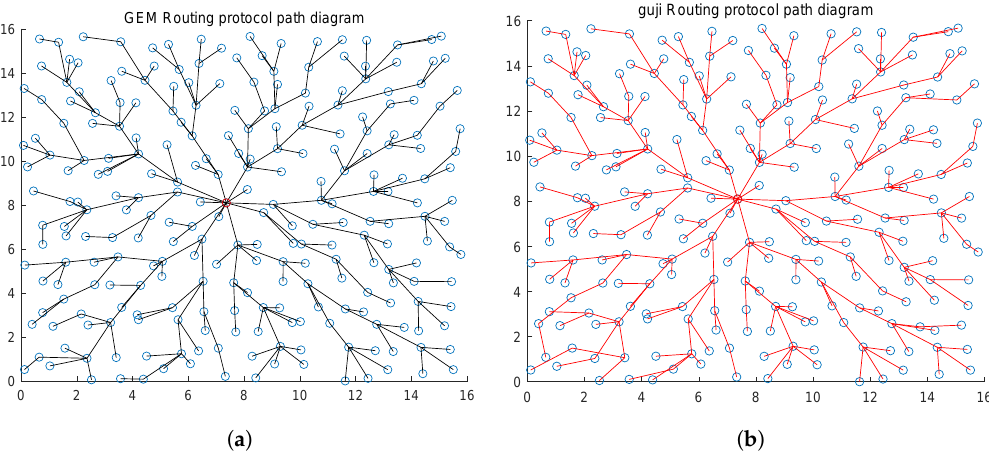
Figure 11. Part ( a ) is the original topology of the target network of GEM routing protocol, and Part ( b ) is the topology rebuilt by the